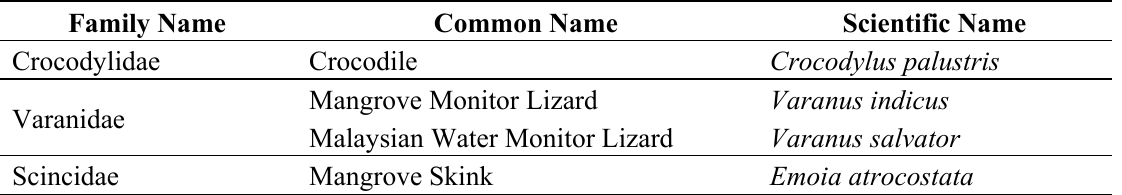
Table 3. List of reptile species detected at Marudu Bay mangrove river tributaries.